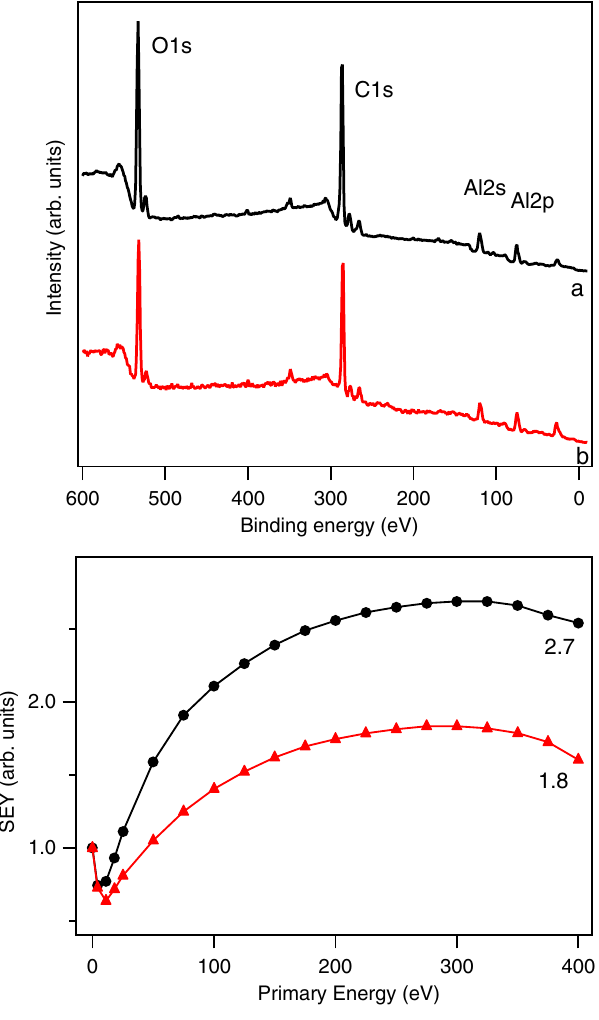
FIG. 4. Top: XPS survey spectra; bottom: SEY curves vs electron beam energy measured on the PETRA III Al sample. (a), (black) as-received and (b), (red) after e (cid:1) beam irradiation, 500 eV, 1 : 2 (cid:3) 10 (cid:1) 1 C = mm 2 . The numbers in the bottom panel value of each report the (cid:1) max